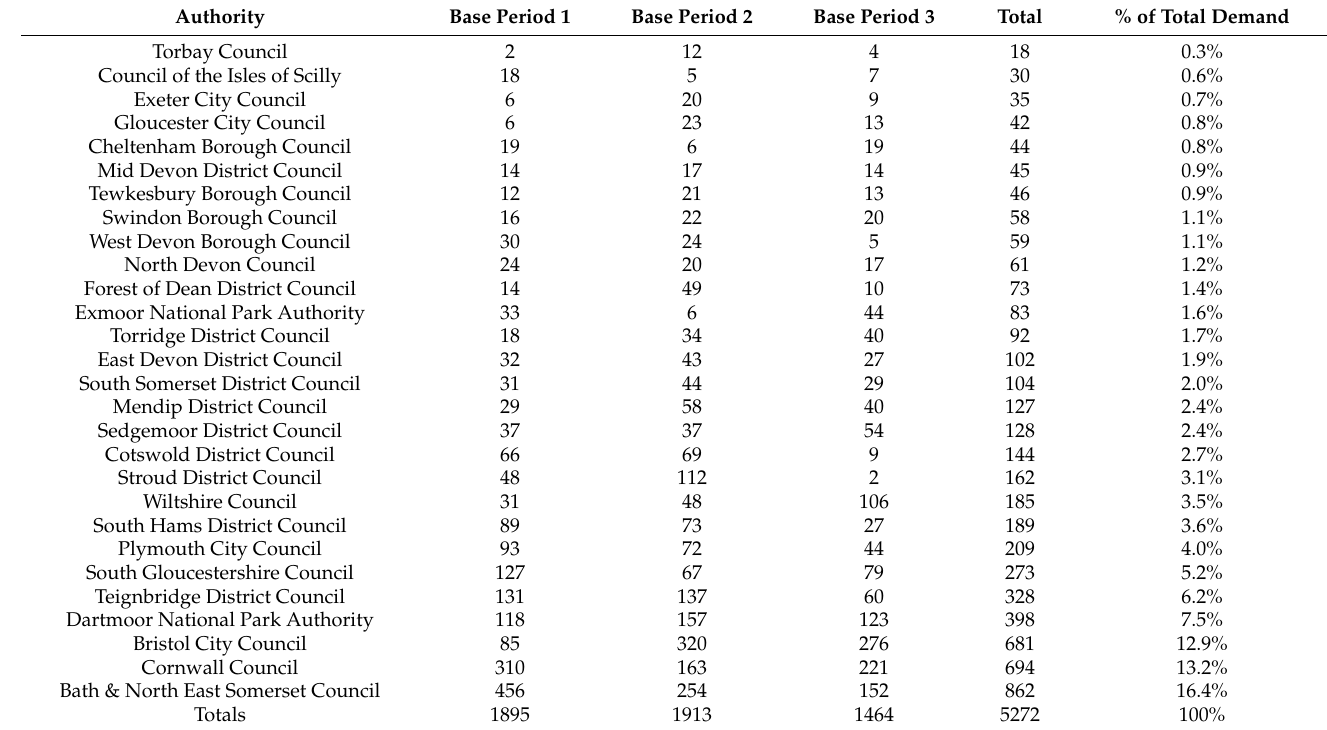
Table 3. Total demand recorded on Registers.